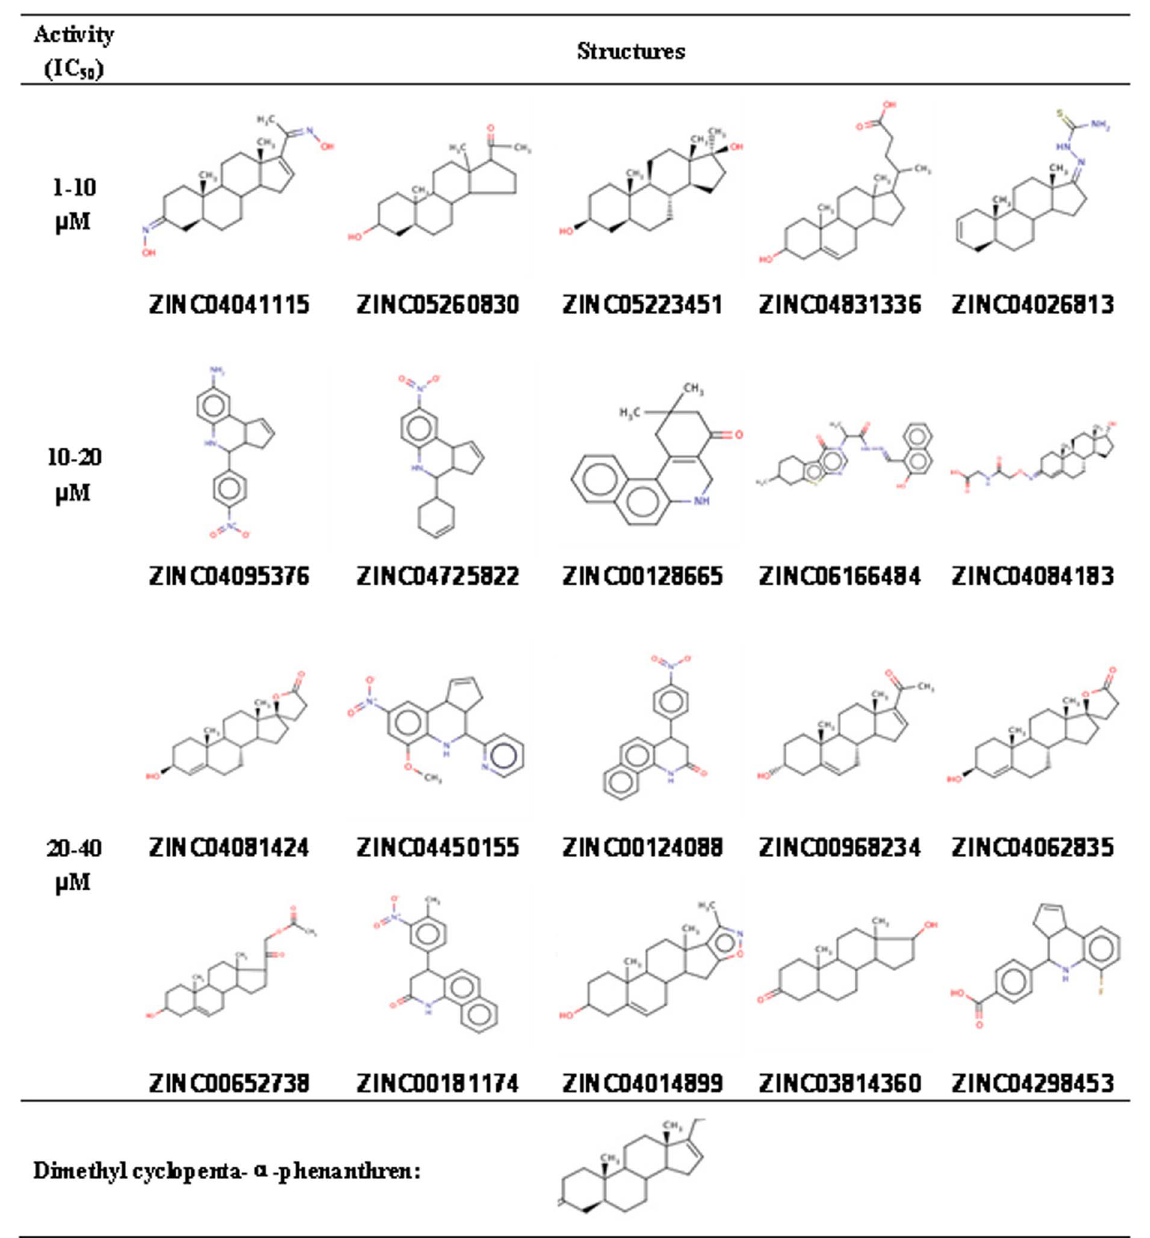
Figure 3. Structures of the top 20 hit compounds against binding of VA387 to the A and B saliva.